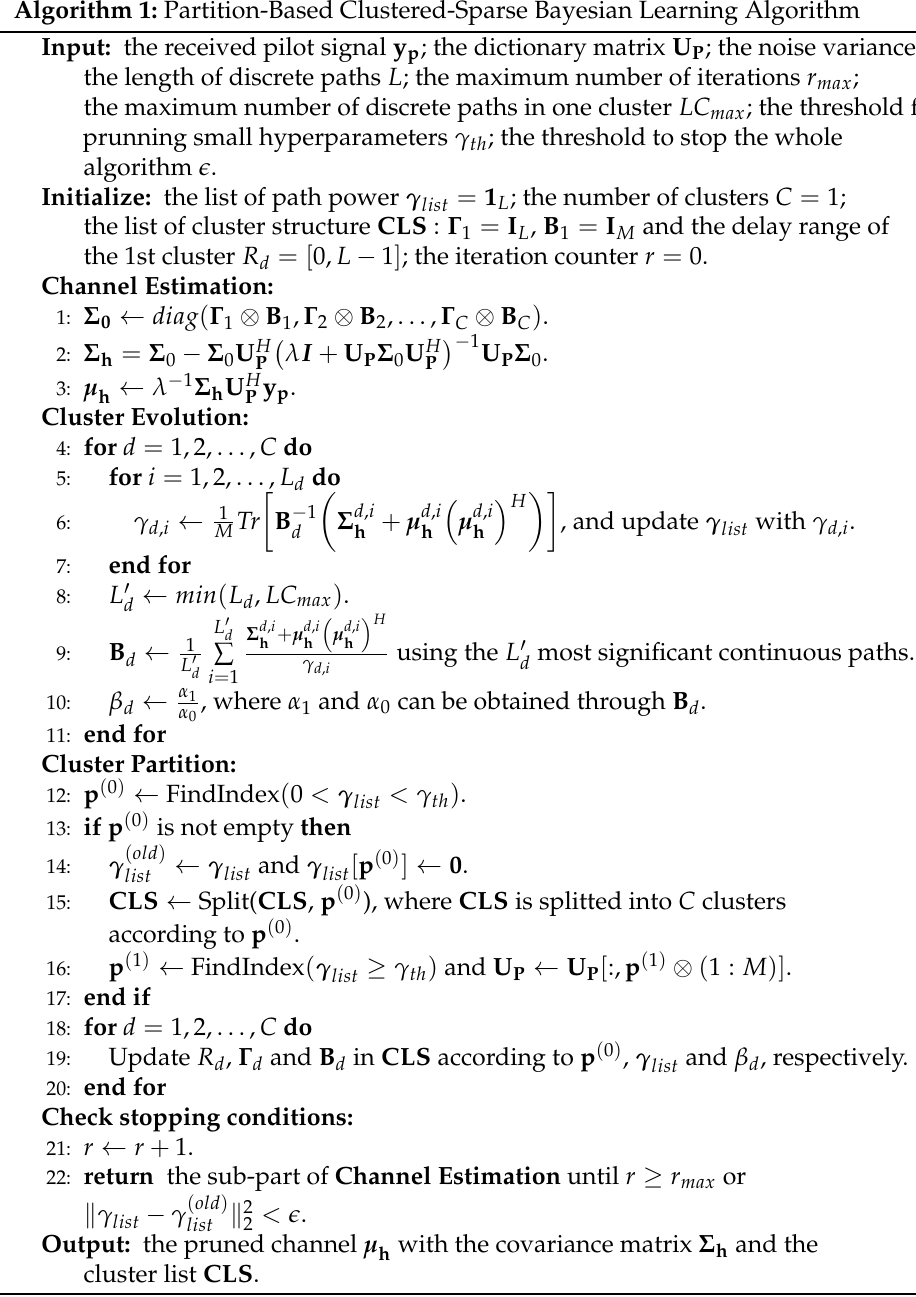
Algorithm 1: Partition-Based Clustered-Sparse Bayesian Learning